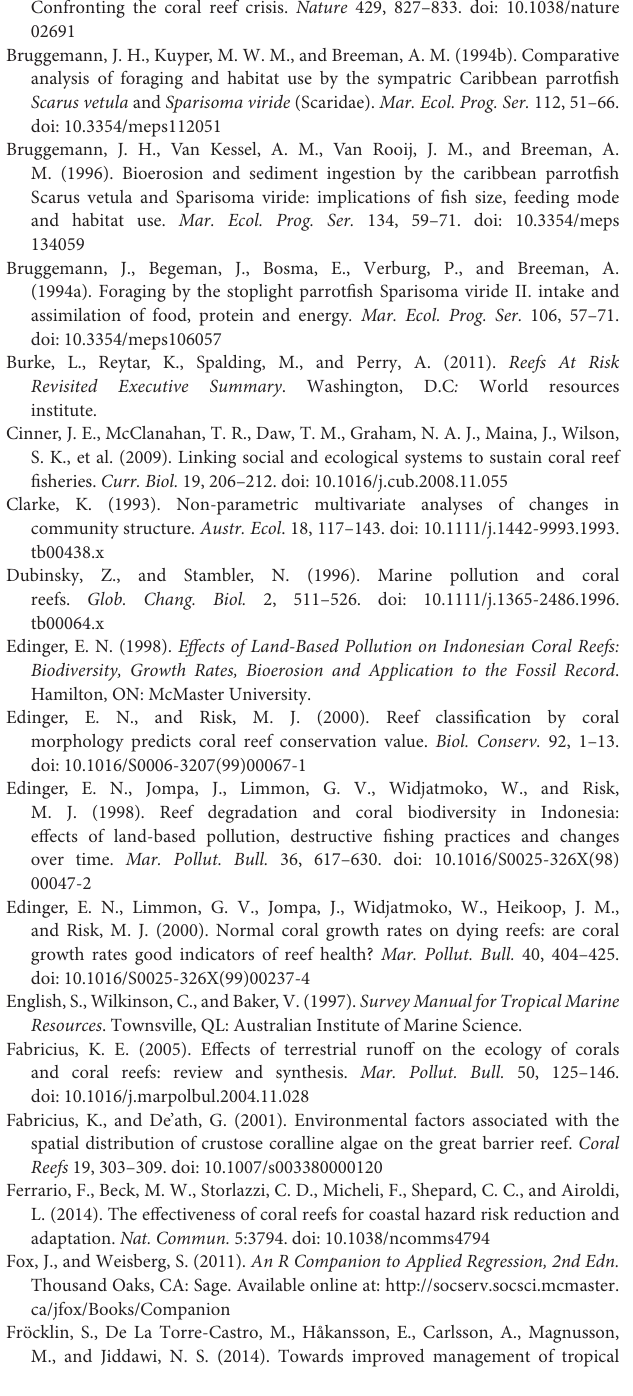
Figure S1 | Sampling effort: illustration of the abundance-based functional rarefaction. The solid line represents the mean cumulative values and the gray area its associated confidence interval.